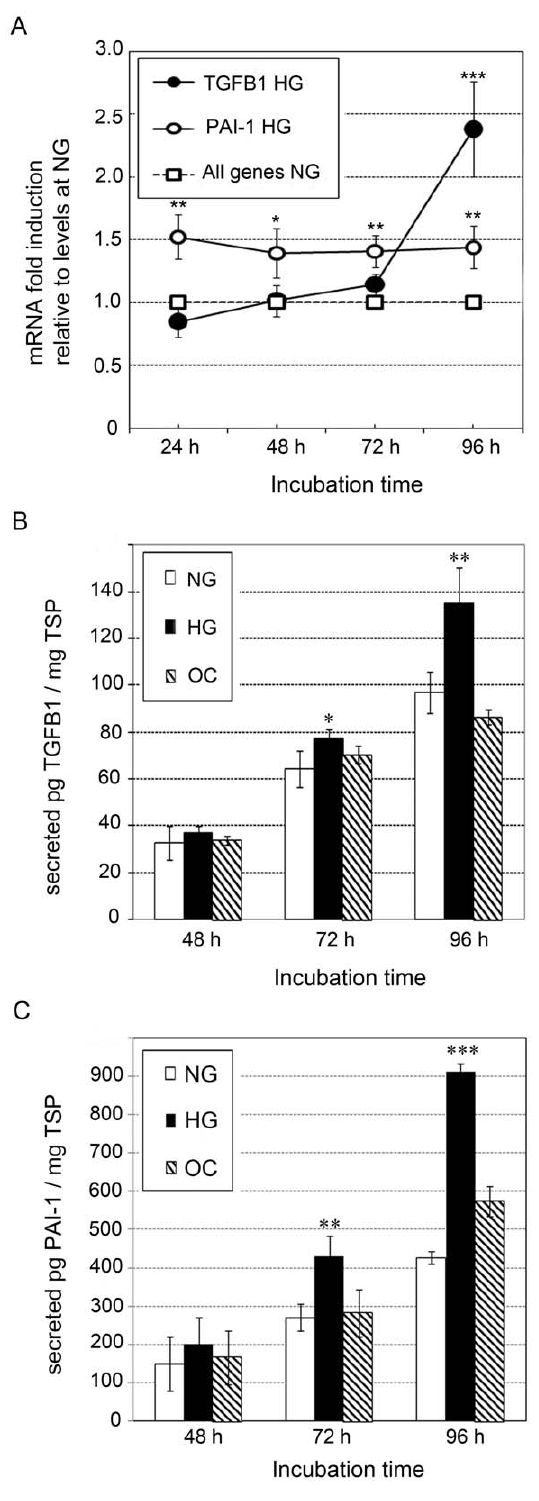
Figure 2. Effect of glucose on TGFB1 and PAI-1 expression in MC. ( A ) Relative quantification of TGFB1 and PAI-1 mRNA by TaqMan qPCR. The mRNA level for all the genes was arbitrary set to 1 under NG conditions at each time point. Data are presented as mRNA fold- increase in MC incubated in HG or NG OC conditions. Quantification of secreted TGFB1 ( B ) and PAI-1 ( C ) proteins by sandwich ELISA. Data are expressed as picograms of PAI-1 or TGFB1 per total soluble protein (TSP). Results represent average of three independent